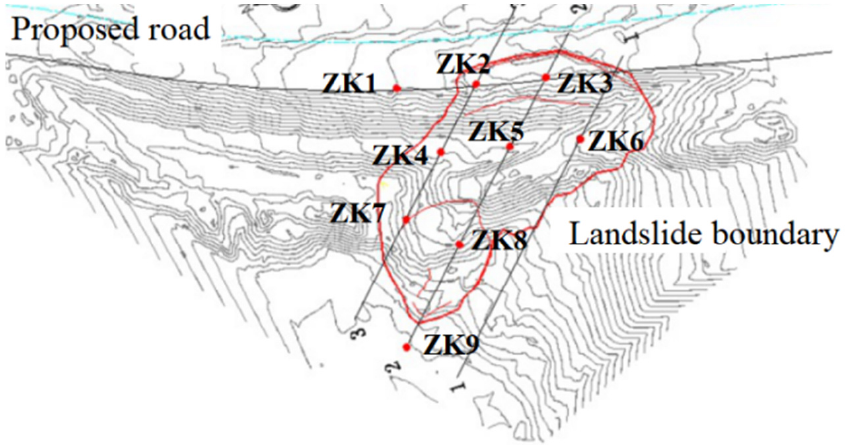
Figure 9. Scope of landslide.